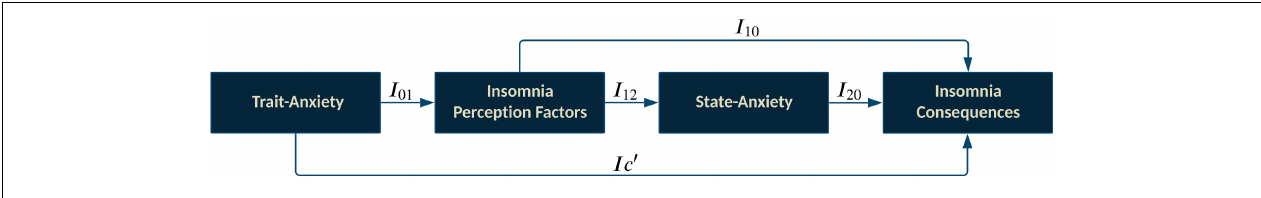
FIGURE 3 | Insomnia mediator model includes the direct effect of trait-anxiety on Insomnia consequences (I c (cid:48) ); Ind-1 [ I 01 → I 10 ]: Trait-anxiety → Insomnia perception factors → Insomnia consequences; Ind-2 [ I 01 → I 12 → I 20 ]: Trait-anxiety → Insomnia perception factors → State-anxiety → Insomnia consequences; Covariates: Confounding factors and Physiological problems.